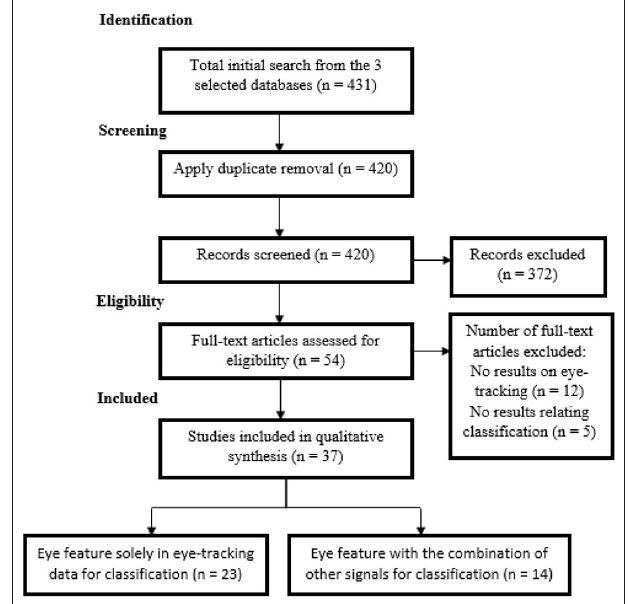
are “eye tracking,” “eye tracker,” “eye,” “gaze,” and “pupil.”